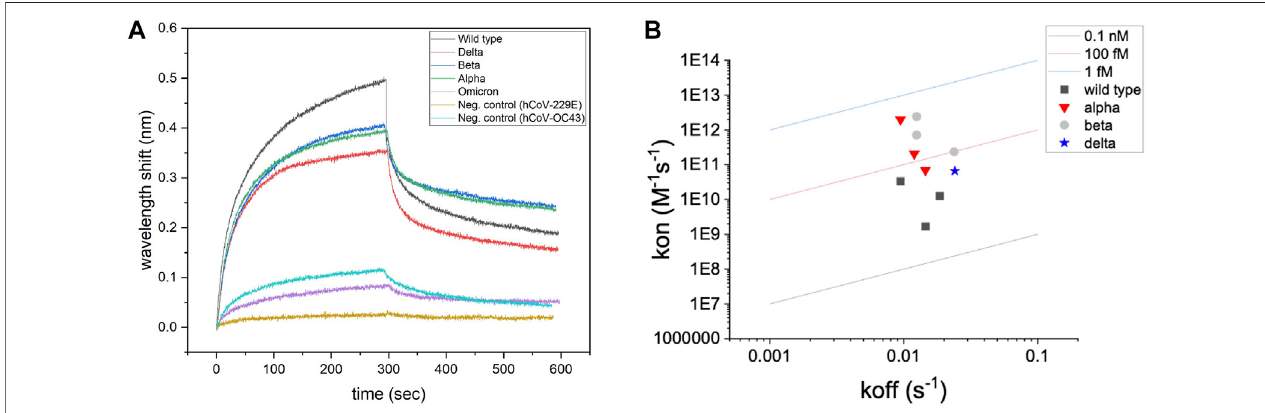
FIGURE 1 | Screening of binding with biolayer interferometry. (A) Representative binding signatures of truncated hACE2 toward SARS-CoV-2 UV-attenuated virions (including wild type and four variants). hCoV-OC43 (common cold Betacoronavirus) and hCoV-229E (common cold Alphacoronavirus) were tested as negative controls for benchmarking. (B) Regression (hyperbolic) modeling for screening hACE2 – SARS-CoV-2 interactions.